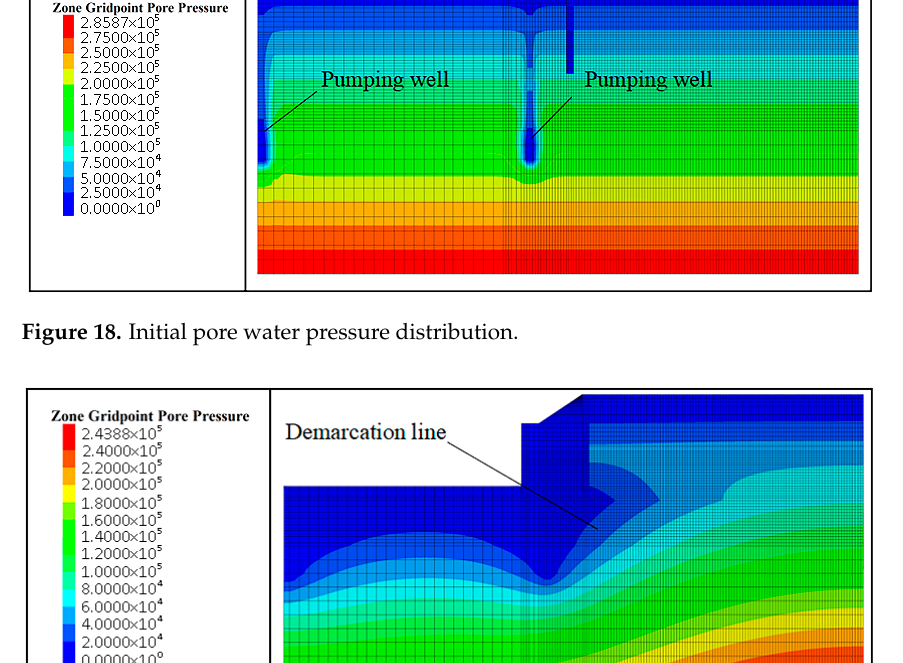
Figure 20. Surface settlement curve around the foundation pit under different working conditions .